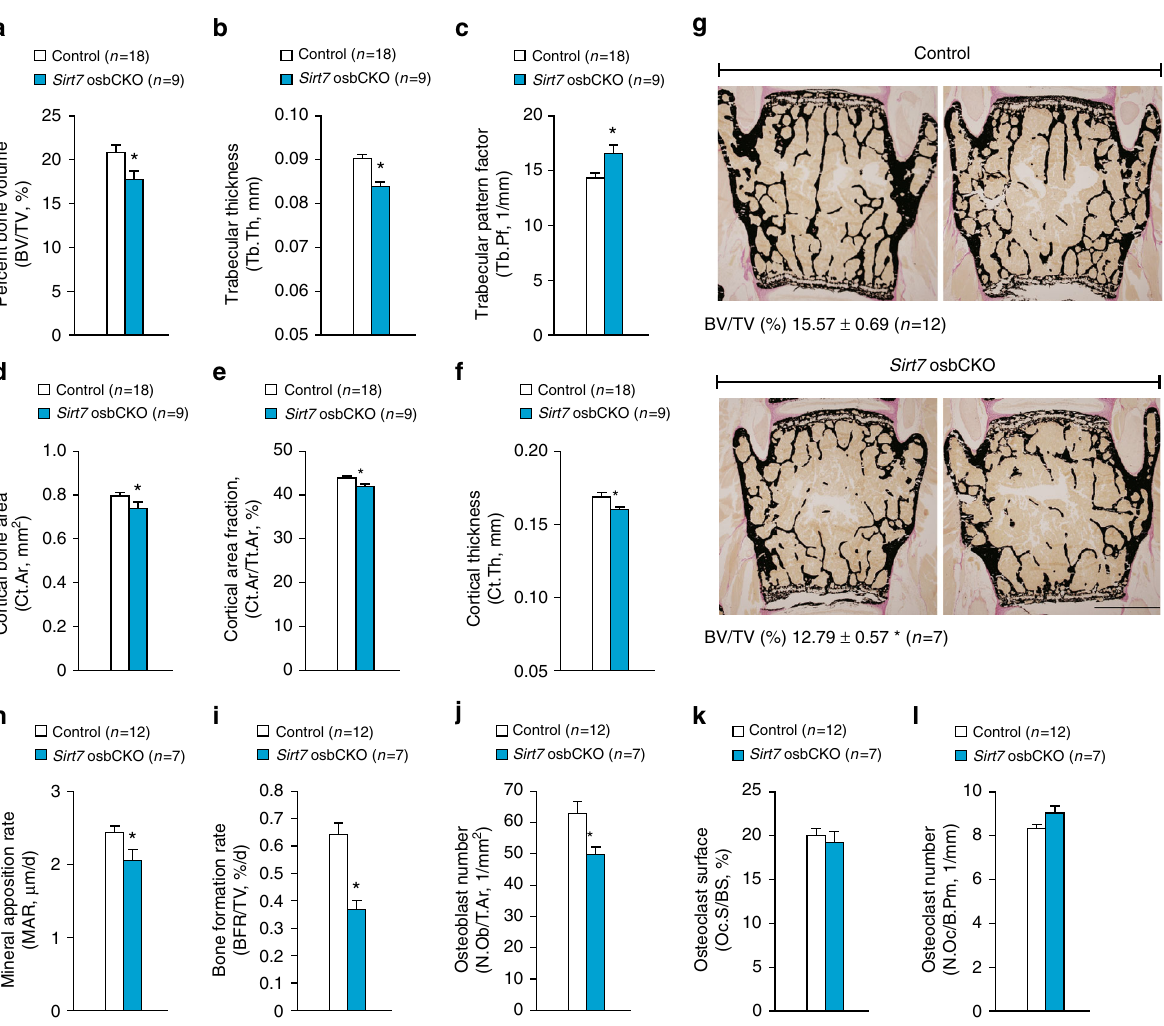
Fig. 4 Osteoblast-speci fi c Sirt7 KO mice exhibit reduction of bone mass due to decreased bone formation. a – f μ CT analysis of the distal femur in 15-week- old female Sirt7 osbCKO mice and control mice. Trabecular BV/TV ( a ), Tb.Th ( b ), Tb.Pf ( c ), Ct.Ar ( d ), Ct.Ar/Tt.Ar ( e ), and Ct.Th ( f ). g – l Static and dynamic bone histomorphometric analyses of the lumbar spine (L4) in 15-week-old female Sirt7 osbCKO mice and control mice. Representative von Kossa- stained images and BV/TV ( g ), as well as MAR ( h ), BFR/TV ( i ), N.Ob/T.Ar ( j ), Oc.S/BS ( k ), and N.Oc/B.Pm ( l ). Data are shown as the mean ± generated ten different lysine to arginine replacement (KR) mutants and analyzed the transcriptional activity of each OSX mutant. We found that the OSX (K368R) mutant showed a marked increase of transcriptional activity by more than 4-fold compared with WT OSX (Fig. 6c). To assess the in fl uence of OSX protein stability, we treated with a proteasome inhibitor (MG132) before analyzing its transcriptional activity. The OSX (K368R) mutant also showed elevation of transcriptional activity after MG132 treatment (Supplementary Fig. 4a), suggesting that K368 was a strong candidate as a target of SIRT7 and that post- translational modi fi cation of OSX at K368 attenuated its N-terminal transactivation activity. Notably, Sirt7 de fi ciency did not reduce transcriptional activity of the GAL4DBD-OSX (K368R) mutant in MC3T3-E1 cells (Fig. 6d). Also, over- expression of the OSX (K368R) mutant rescued impairment of mineralization in cultures of Sirt7 KD MC3T3-E1 cells (Fig. 6e). Interestingly, K368 of mouse OSX is conserved in humans, birds, frogs, and zebra fi sh (Supplementary Fig. 4b). Taken together, these fi ndings support the assumption that SIRT7 promotes N- terminal transactivation activity of OSX by deacylation of C- terminal K368 (Fig. 6f).